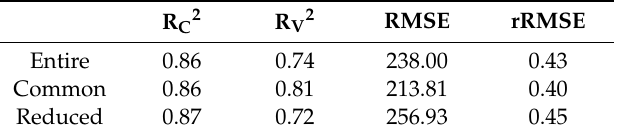
Table 3. Summarized mean values for biomass regression models (Calibration: R C2 : coe ffi cient of